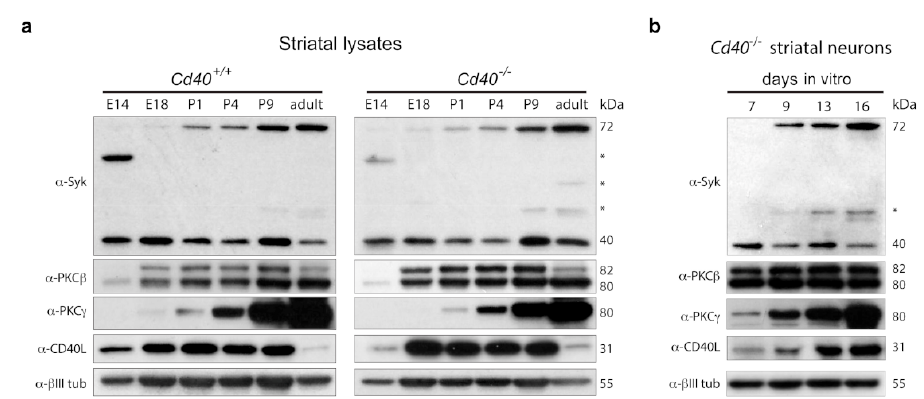
Figure 6. Expression of Syk, PKC β , PKC γ , and CD40L. ( a ) Representative western blot of the expression of Syk, PKC β , PKC γ , and CD40L in striatal lysates from Cd40 +/+ and Cd40 − / − at the indicated ages. ( b ) Representative western blot of the expression of Syk, PKC β , PKC γ , and CD40L in Cd40 − / − striatal neurons cultured for the days indicated. Anti- β III tubulin was used as a loading control. * indicates nonspecific